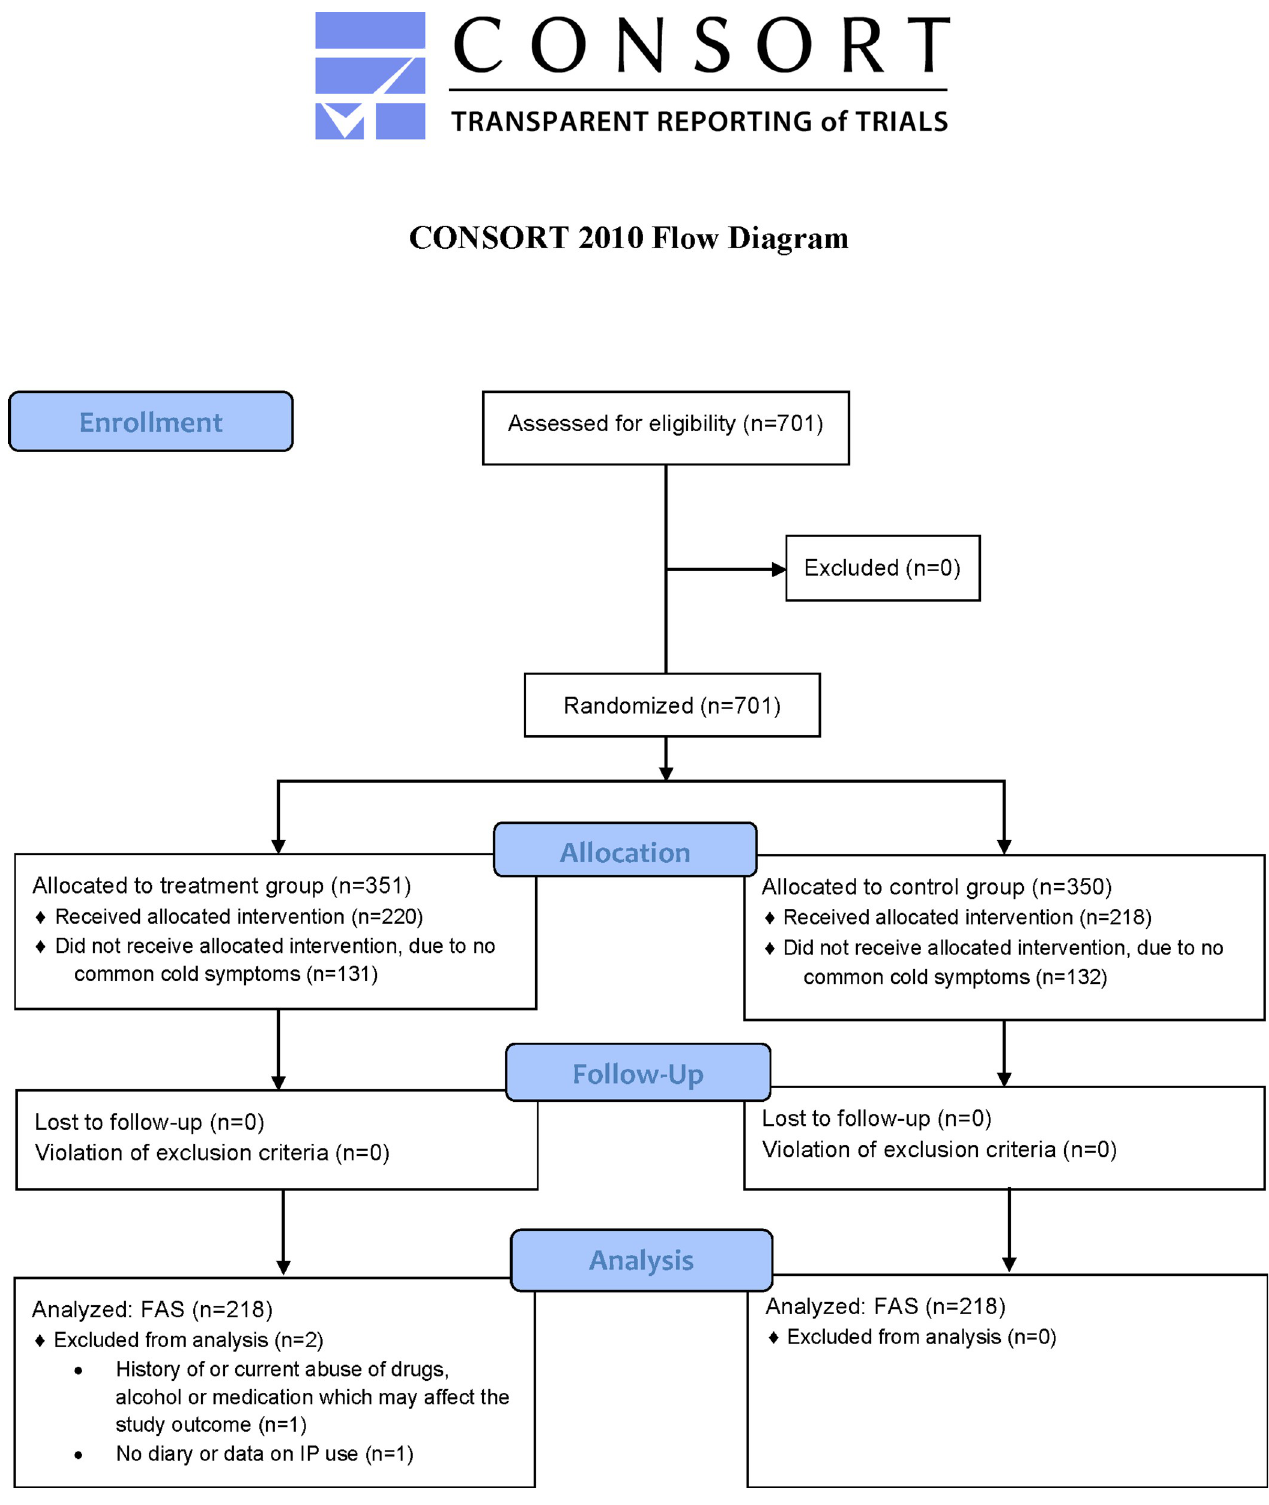
Fig 1. Trial profile.